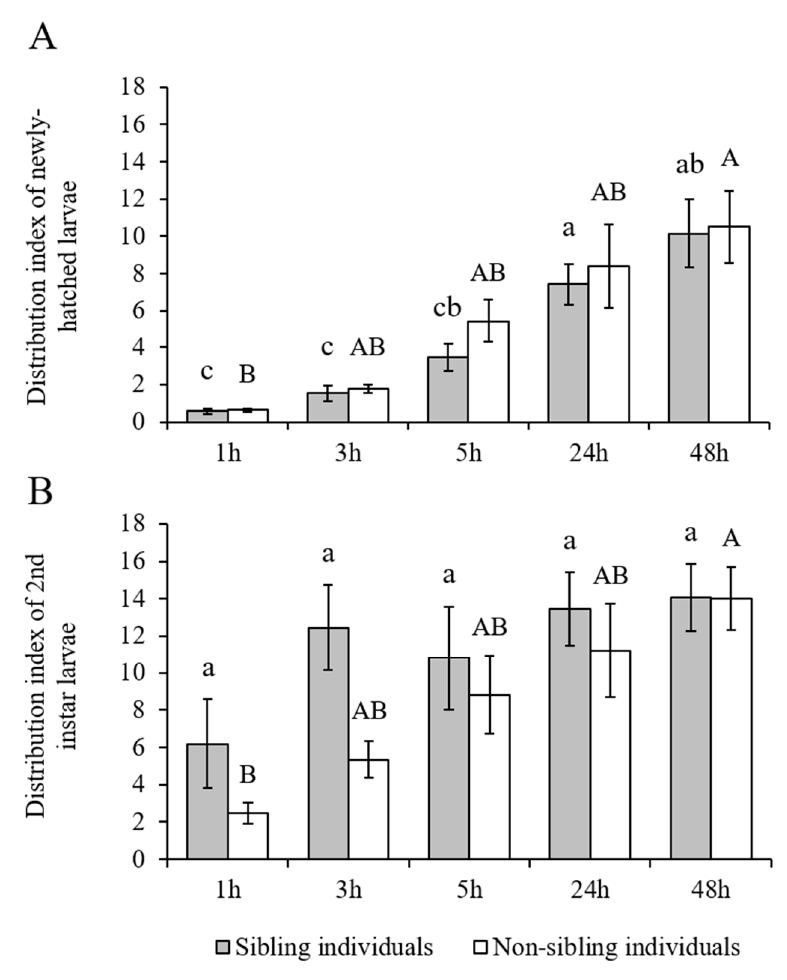
Figure 5. ( A ) Aggregation index of newly hatched or ( B ) second-instar larvae of Heortia vitessoides